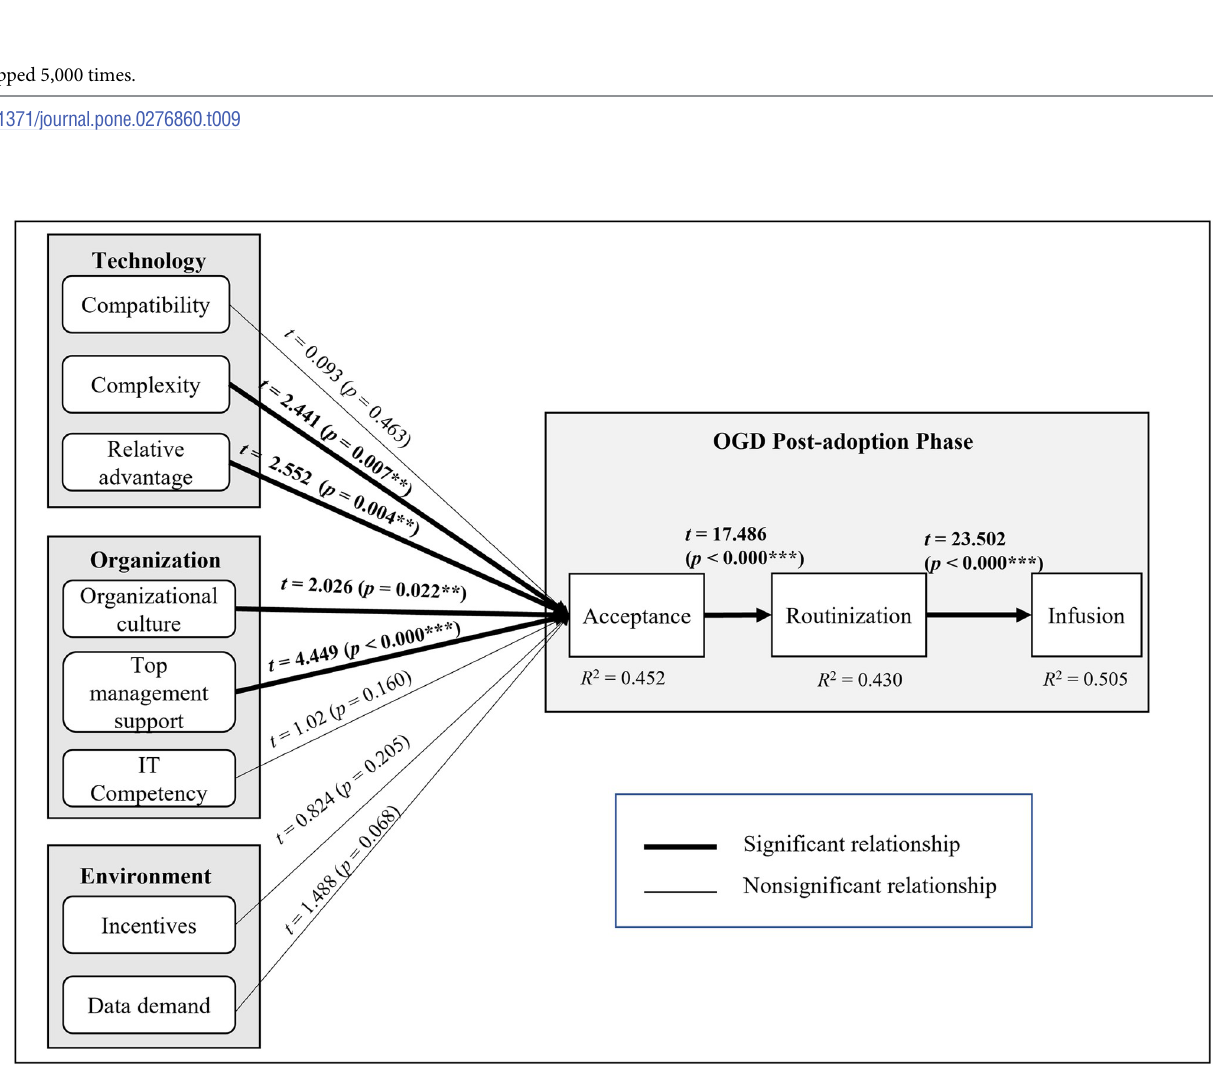
Fig 4. Results for structural model